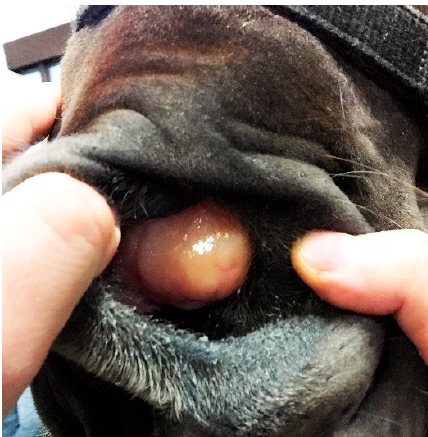
Figure 1. Firm mass protruding from the left nasal cavity of a mare with breathing difficulties.